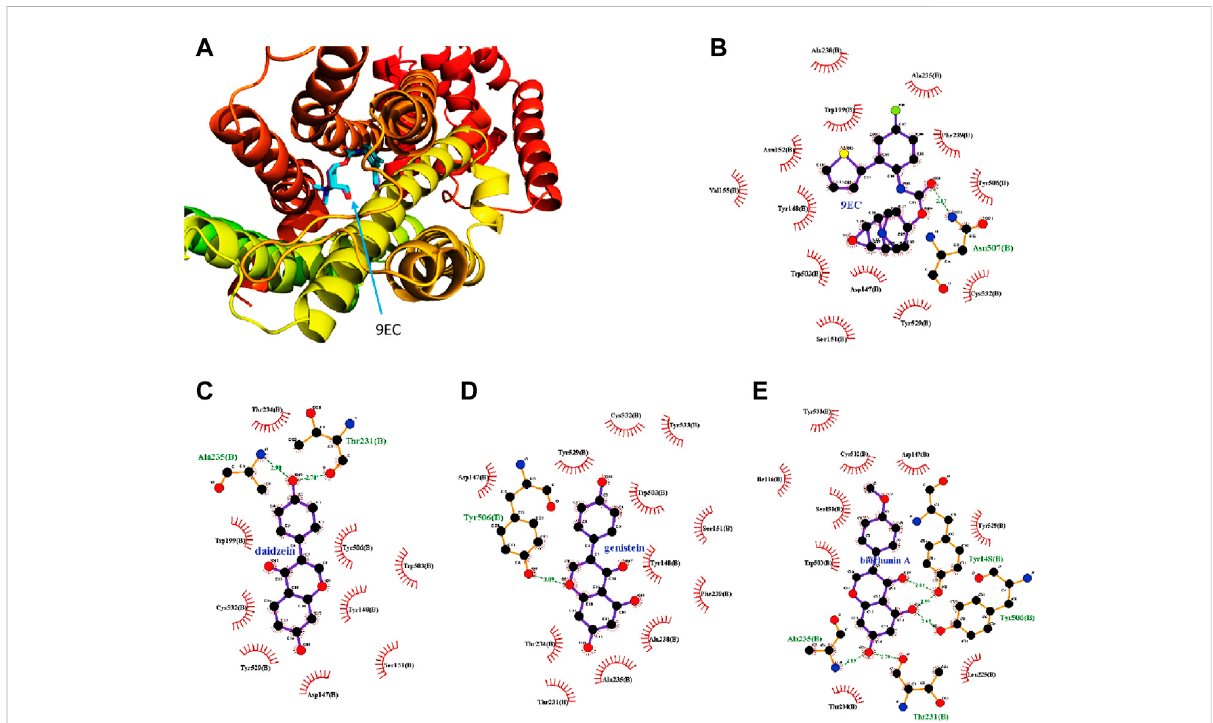
the M3 receptor (PDB ID 5ZHP chain B). The three-dimensional diagram illustrates the interactions of redocked 9EC (purple sticks) and the crystallized one (bluesticks)withtheM3receptor withthesamebindingposition (A) which shows thehigh accuracyofthecurrentdocking method. The two-dimensional diagrams show theinteractions of 9EC (B) , daidzein (C) , genistein (D) , and biochanin A (E) with the amino acid residuesin the binding pocket of the M3 receptor. The spoked arcs show amino acid residues providing nonbonded interactions with the ligand. Green arrows with respective distances represent H-bonding between ligands and speci fi c amino acid